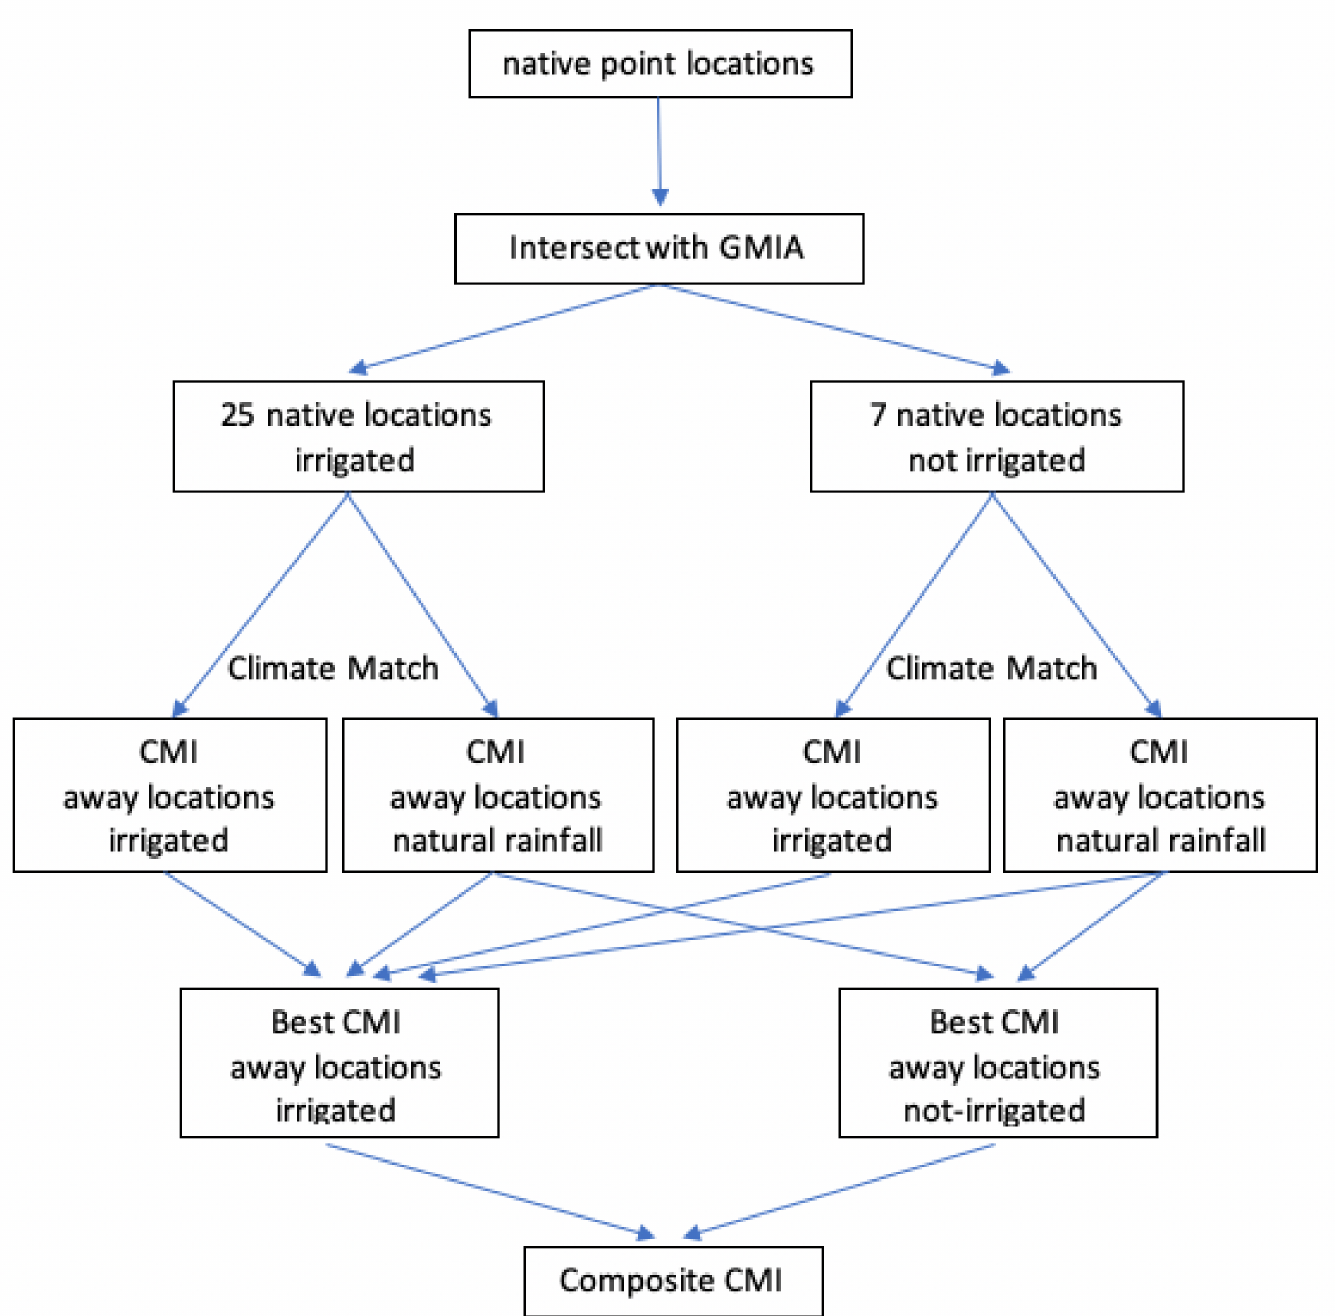
Figure A1. Schematic diagram of methodology for Climate Match (Regional)